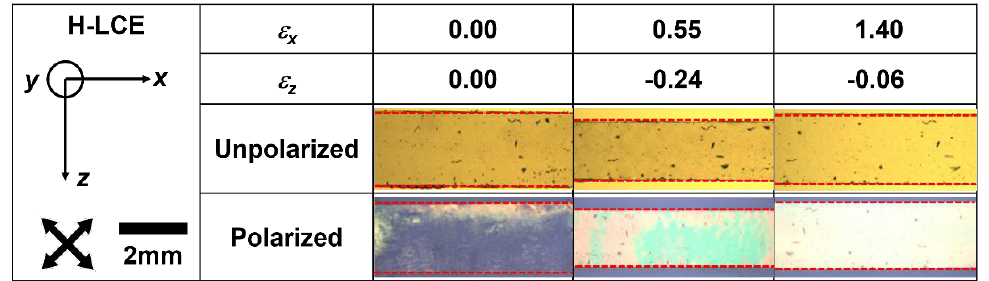
Figure 4. Photomicrographs of the H-LCE during mechanical deformation in the x – z plane. The red dashed lines clarify the positions of the sample edges. When ε x is ~ 0.55, the width of the LCE is a minimum, beyond which it clearly increases with further strain, i.e., it shows an auxetic response. The H-LCE sample has almost regained its original width at a strain of ~ 1.4.